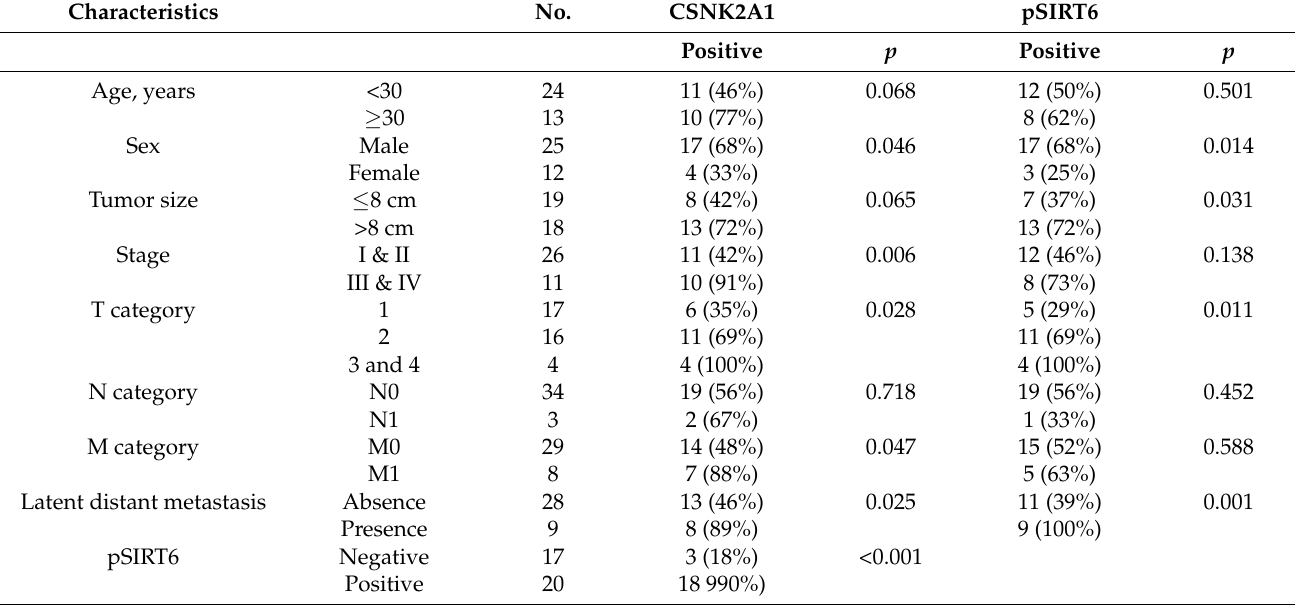
Table 1. The clinicopathological characteristics of 37 osteosarcomas and their association with the immunohistochemical expression of